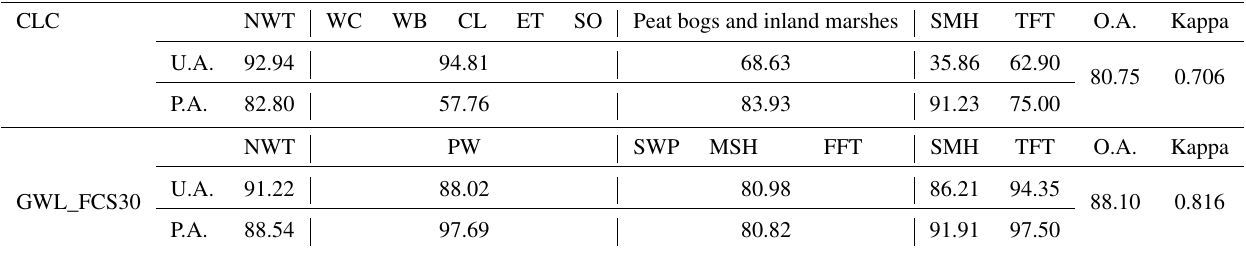
80.75 0.706 88.10 0.816